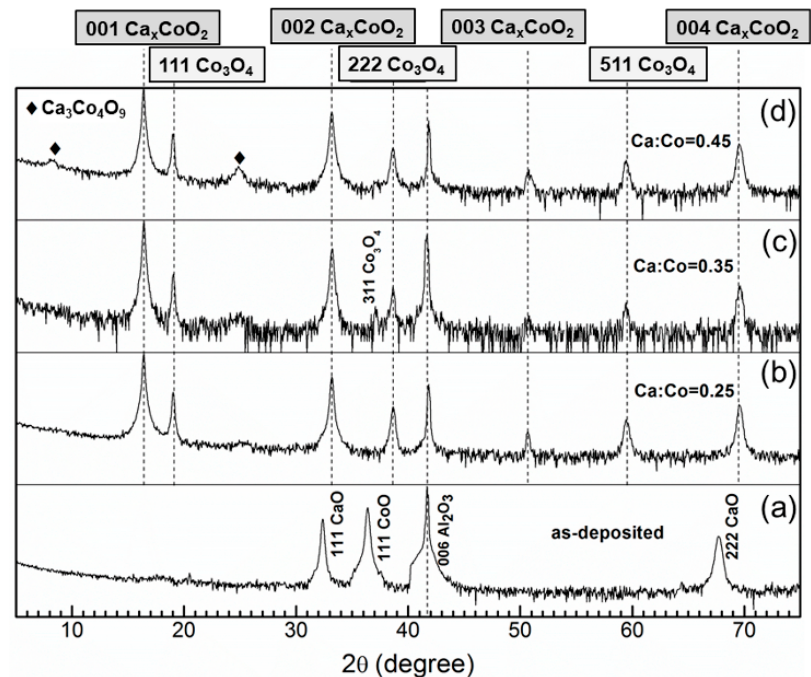
Figure 2. θ –2 θ XRD patterns of ( a ) as-deposited CaO–CoO film and annealed films with ( b ) Ca:Co = 0.25, ( c ) Ca:Co = 0.35, ( d ) Ca:Co = 0.45.